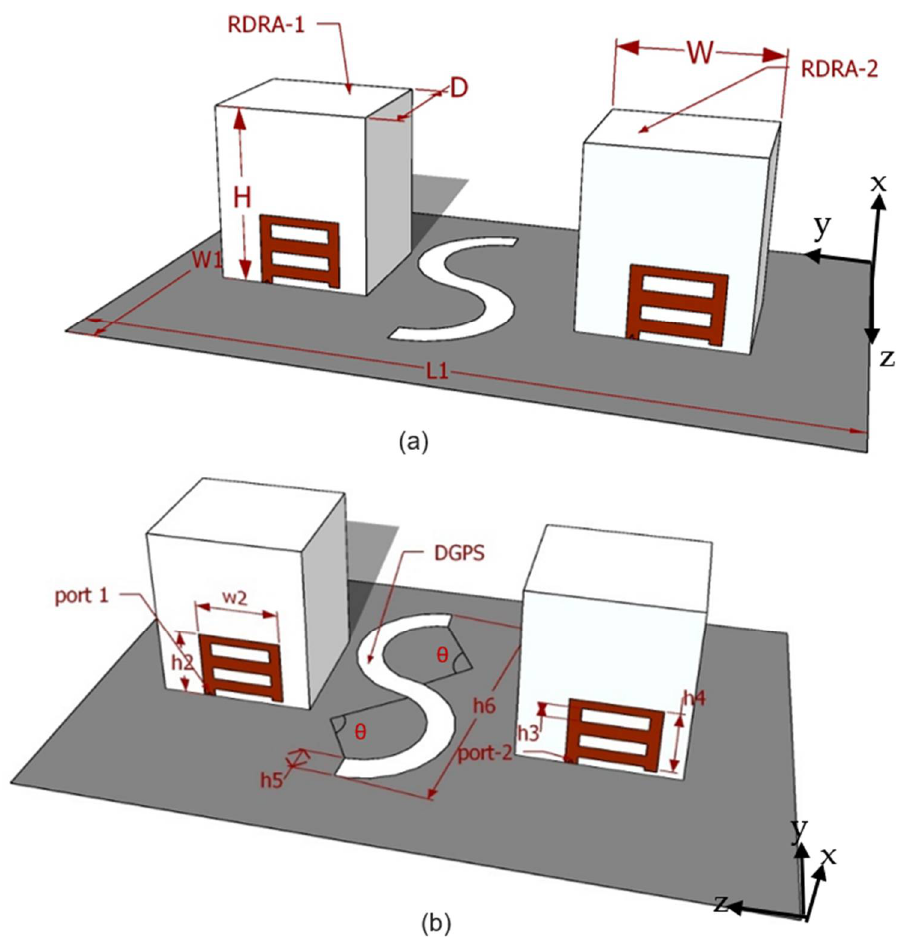
Figure 1. Graphic diagram of the desired MIMO antenna: ( a ) 3D view point; ( b ) feed and DGPS structure. Table 1. Optimized values of the proposed MIMO antenna’s parameters. Element.